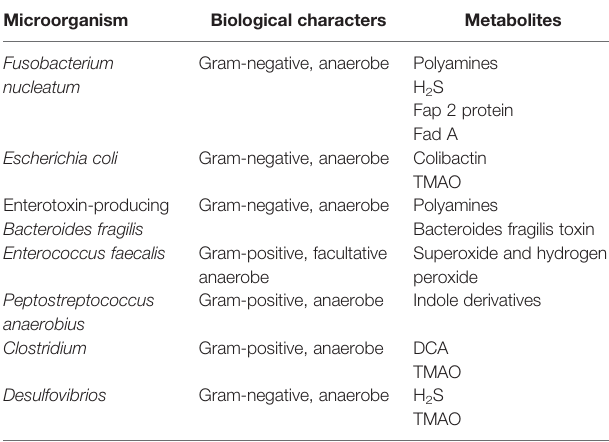
TABLE 1 | Summary of individual microbes and their corresponding metabolites probably involved in colorectal